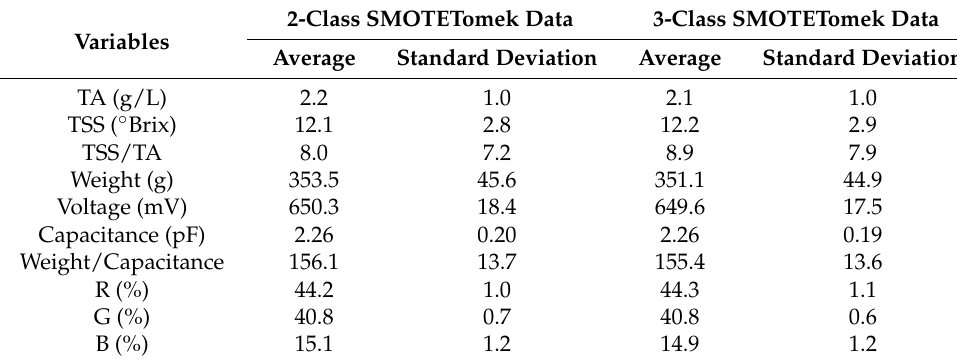
Table 6. The average and standard deviation of the original data and over sampling data of 10 variables, as in Table 4, from 100 mango samples.